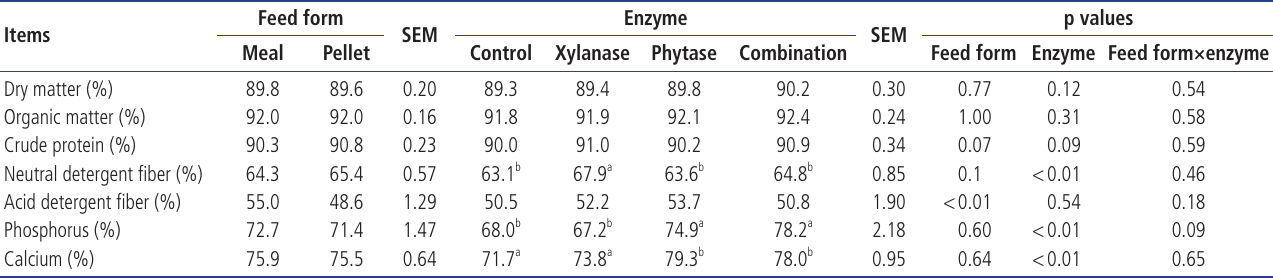
Table 2. Effect of feed form and exogenous enzymes on total tract nutrient digestibility for growing pigs fed wheat-based diets 1)